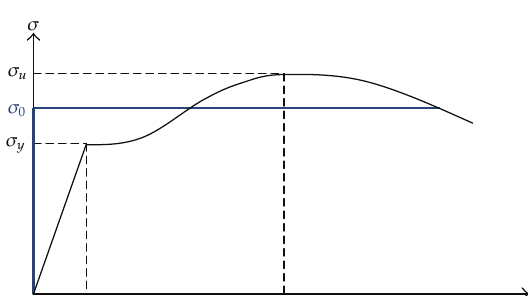
Figure 1: Example of stress-strain curve for mild